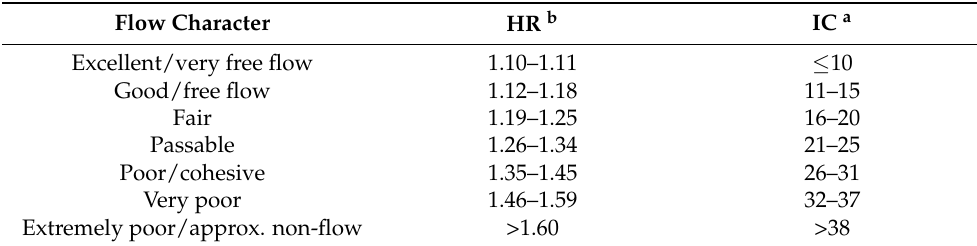
Table 8. Powder flowability based on Hausner Ratio and Carr Index